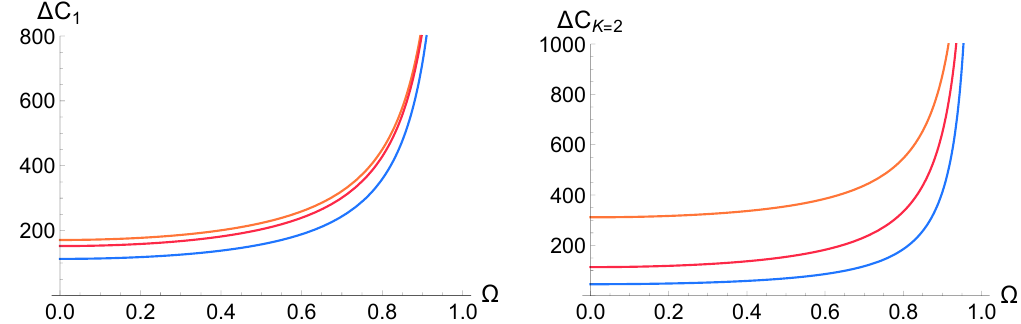
Figure 21 . Complexity of formation as a function of the angular velocity Ω for different values of m . For all curves L = 1 , N = 20000 and T = 100 . From the top down m = 10 − 6 (orange), m = 10 (red) and m = 100 (blue). The divergent behavior as Ω → 1 is apparent for both cost functions.